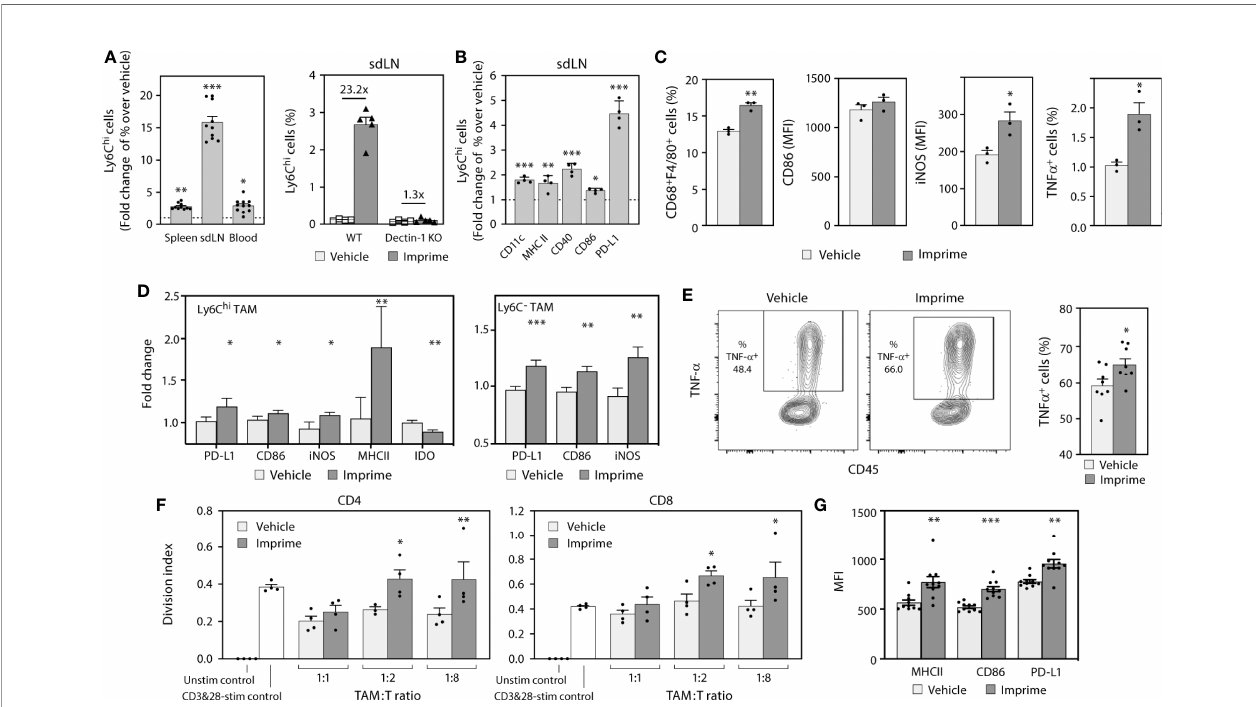
FIGURE 3 | Imprime mobilizes and activates Ly6C + monocytes in tumor-free mice and modulates tumor associated myeloid cells in MC38 syngeneic tumor model. Naïve WT or Dectin-1 KO C57BL/6 mice (n = 3-10) were treated with Imprime or vehicle as described above. (A) Fold change over vehicle in frequency of Ly6C hi monocytes in blood, spleens, and sdLNs of WT or Dectin-1 KO mice at 24 hours; (B) fold increase in activation markers of Ly6C hi monocytes in sdLN, and (C) MFI of activation markers on CD68 + F4/80 + splenic macrophages at 16 hours and percent of LPS-stimulated TNF- a + expressing splenic macrophages were determined by fl ow cytometry. (D) The MC38 syngeneic mouse model was established as described in Materials and Methods. Imprime or vehicle treatment started when tumors reached ~50mm 3 (n = 5-8/treatment group). Activation markers on Ly6C hi and Ly6C - TAM analyzed by fl ow cytometry on day 7 and, (E) LPS-induced TNF- a production in TAMs from a representative mouse and bar graph showing data from individual mouse analyzed by intracellular fl ow cytometry are shown. (F) T cell suppression assay was performed as described in Materials and Methods using enriched CD11b + TAM. (G) MFI of activation markers on mouse m-MDSC (CD11b + Gr-1 lo Ly6c + ) were determined by fl ow cytometry. Representative results from ≥ 2 experiments are shown. All summary data are presented as mean ± SEM. Unpaired Student ’ s t test was used in (A, B, C, E) . Multiple t tests with Holm-Sidak ’ s multiple comparison were used in (D, G) , and One-way ANOVA was used in (F) , and * p < 0.05, ** p < 0.01, *** p <